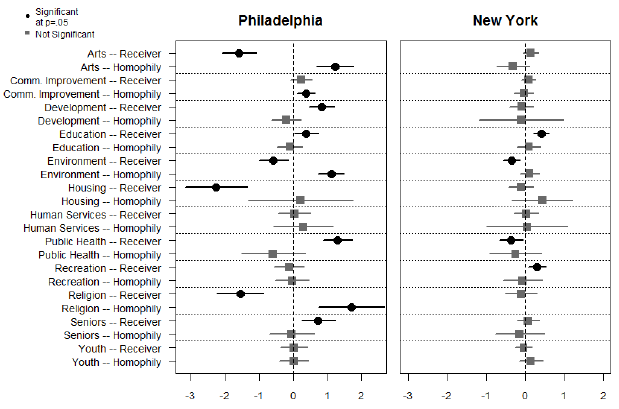
Fig. 6 . Odds ratios for Organizational Focus exponential random graph (ERG) terms for Philadelphia and New York City ERG models.